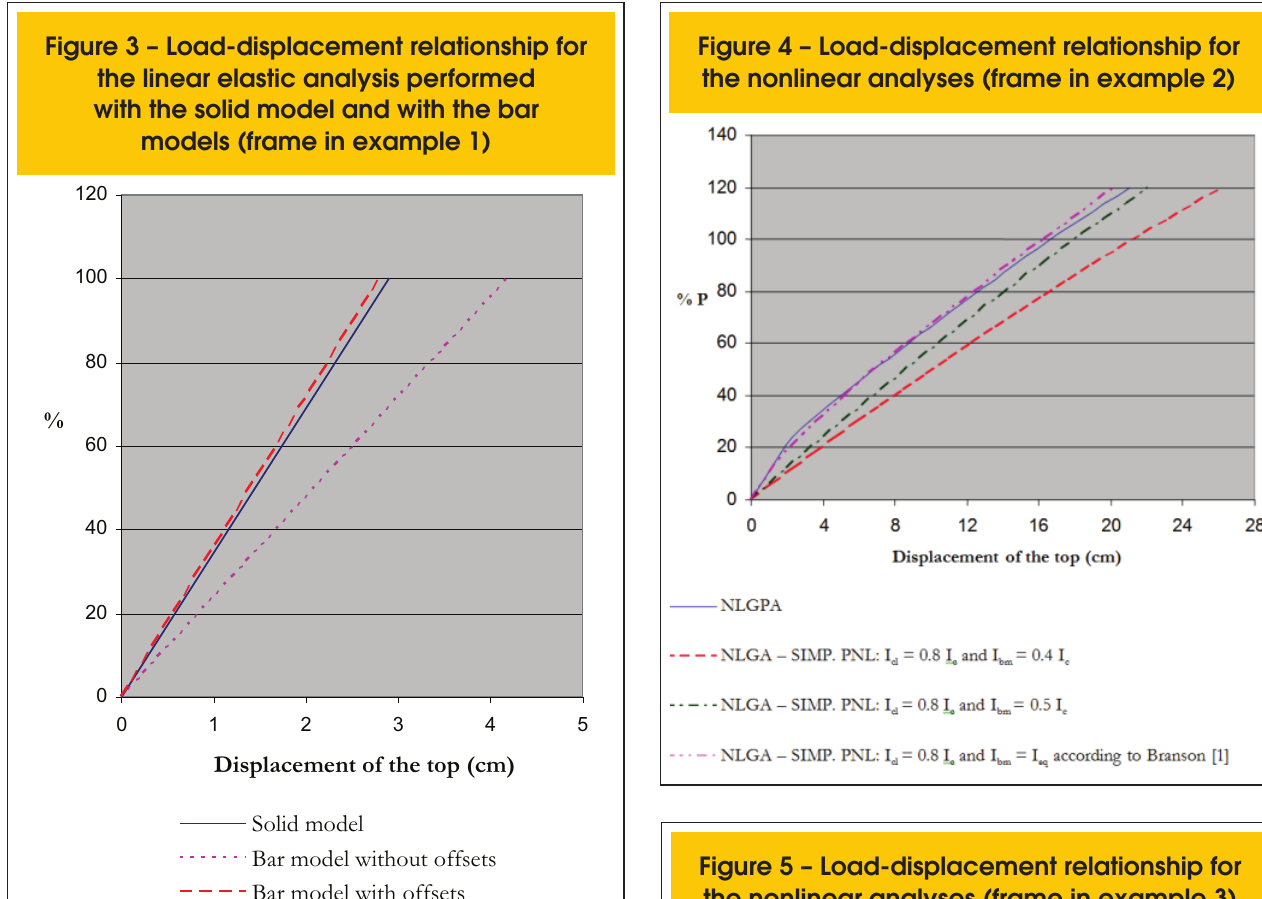
Figure 5 – Load-displacement relationship for the nonlinear analyses (frame in example